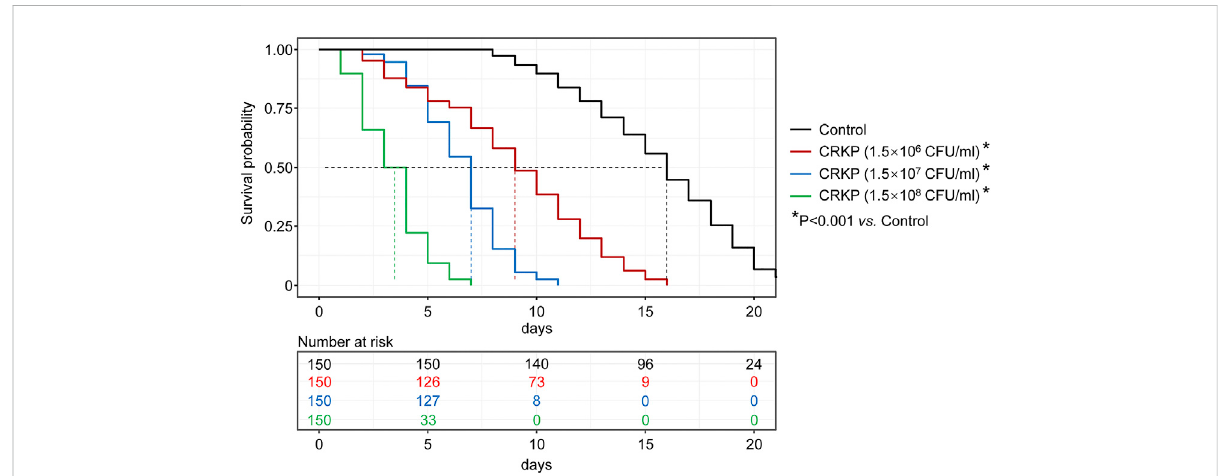
FIGURE 1 C. elegans survival curves following exposure to different CRKP concentrations. Nematodes in the control, 1.5 × 10 6 , 1.5 × 10 7 , and 1.5 × 10 8 CFU/ml groups survived for 22, 15, 11, and 7 days, respectively, with median survival durations in these four respective groups of 16, 9, 7, and 3.5 days. Relative to control group, those in the three infection groups exhibited signi fi cantly impaired survival ( p <